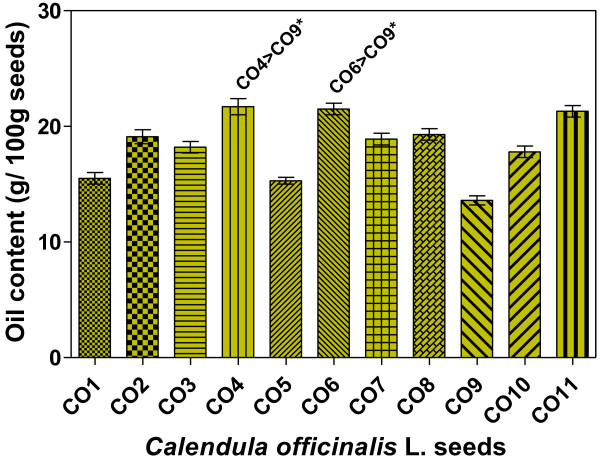
The oil content of Pot marigold (Calendula officinalis L.) seeds. CO1- CO11, pot marigold (Calendula officinalis L.) genotypes. Results are given as mean ± SD (n = 3); * - significant difference, p < 0.05 (using "Kruskal-Wallis non-parametric test" followed by "Dunn's Multiple Comparison Test").